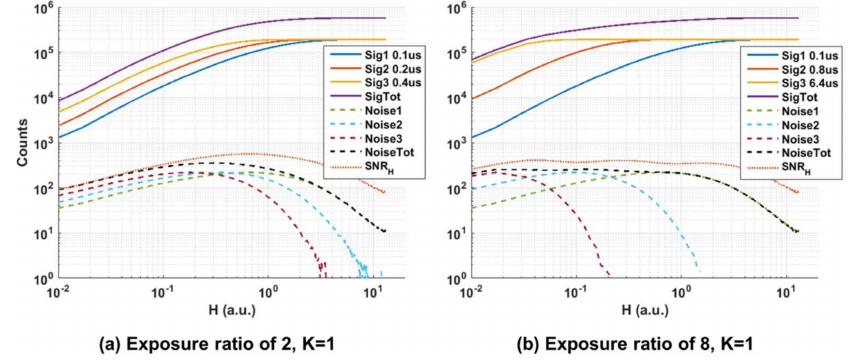
Figure 13. Measured signal, noise and SNR H response for 3 exposure settings and K = 1. ( a ) Exposure ratio of 2. ( b ) Exposure ratio of